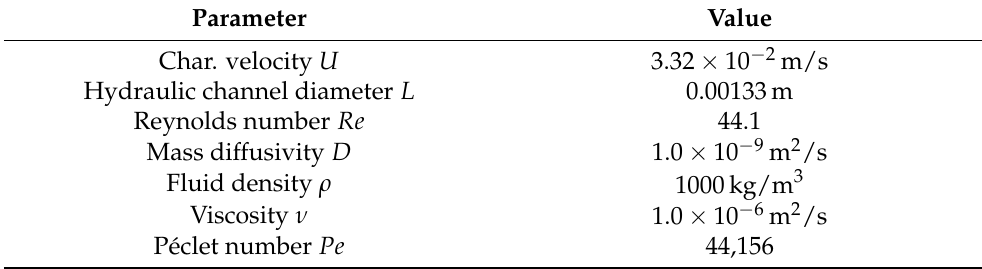
Table 2. Process parameters.